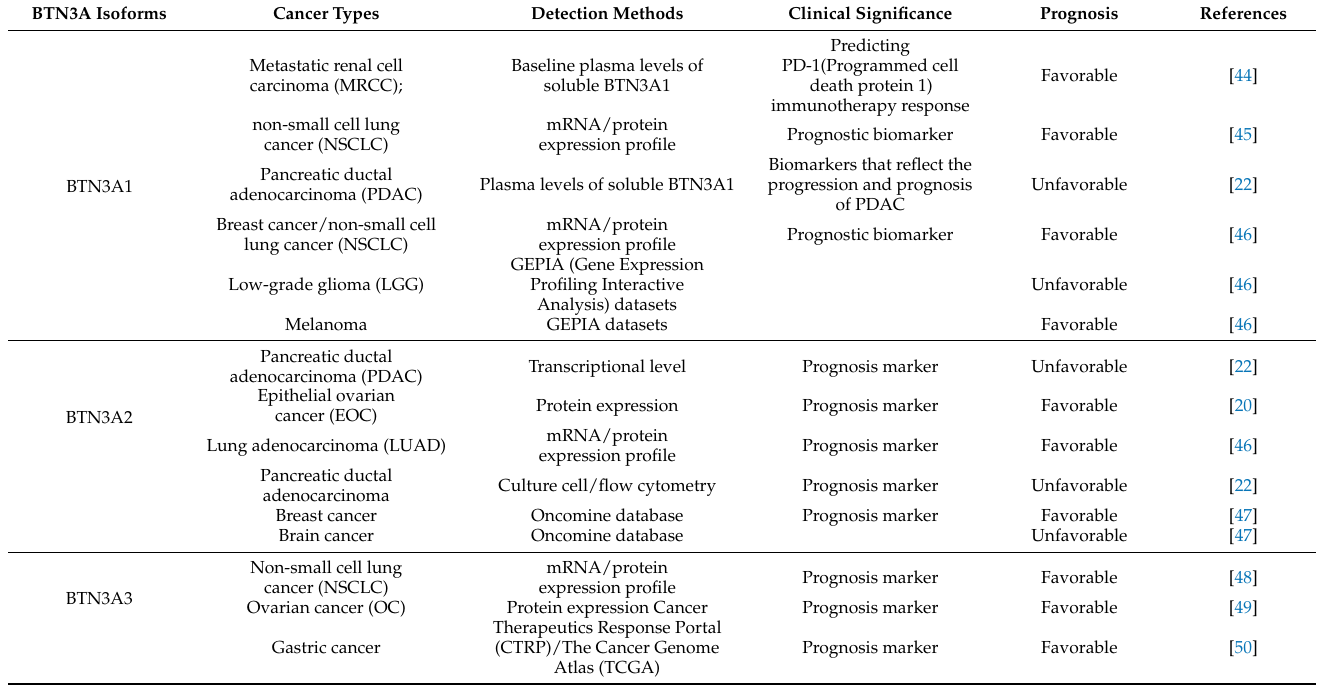
Table 1. Differential prognosis and clinical implication of BTN3A